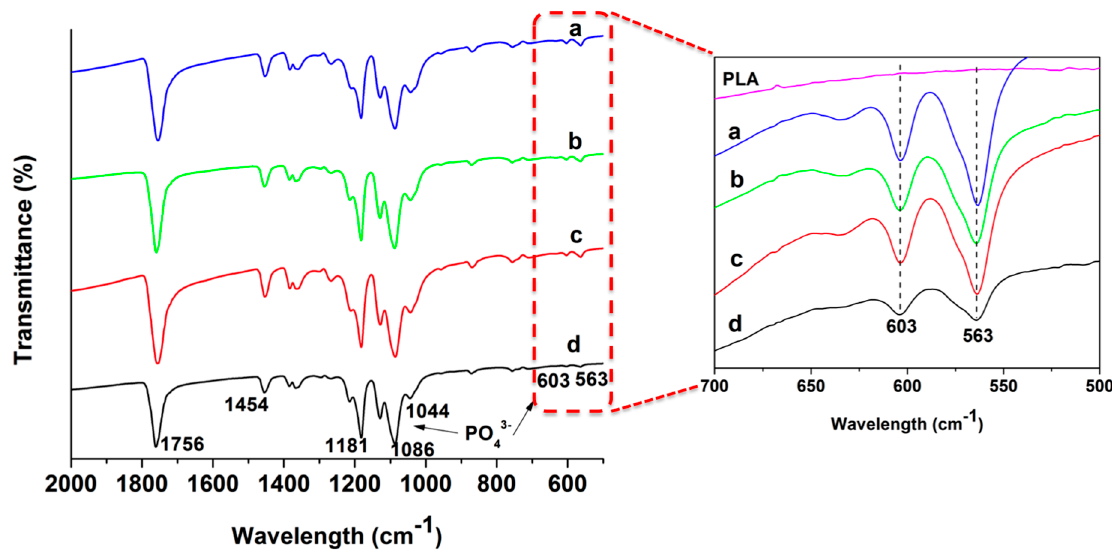
Figure 7. FTIR spectra of ( a ) PLA/15%nHA, ( b ) PLA/15%nHA-1%GO, ( c ) PLA/15%nHA-2%GO and ( d ) PLA/15%nHA-3%GO nanocomposite fibers. The enlarged spectra in the wave number ranging from 500 to 700 cm − 1 are presented.